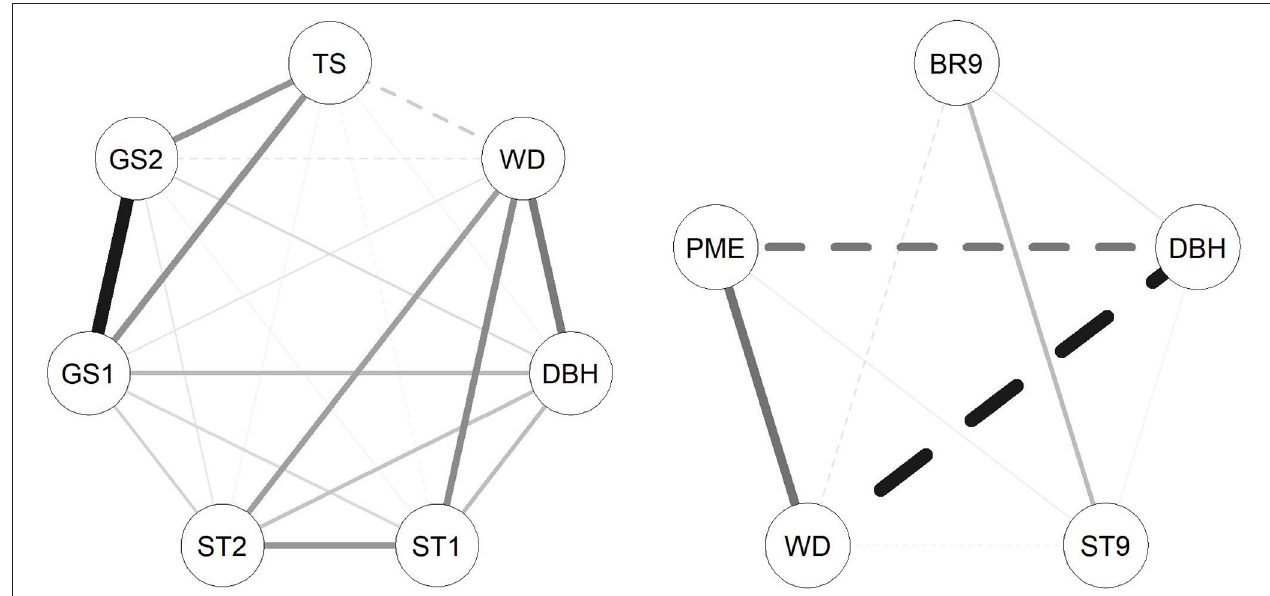
FIGURE 2 | Correlation networks between traits investigated in the E. nitens (left) and P. radiata (right) populations based on genetic correlations estimated in multivariate model using marker-based relationship matrix. Solid lines represent positive correlations and dashed lines represent negative genetic correlations; the thickness of the lines represents magnitude of correlations.